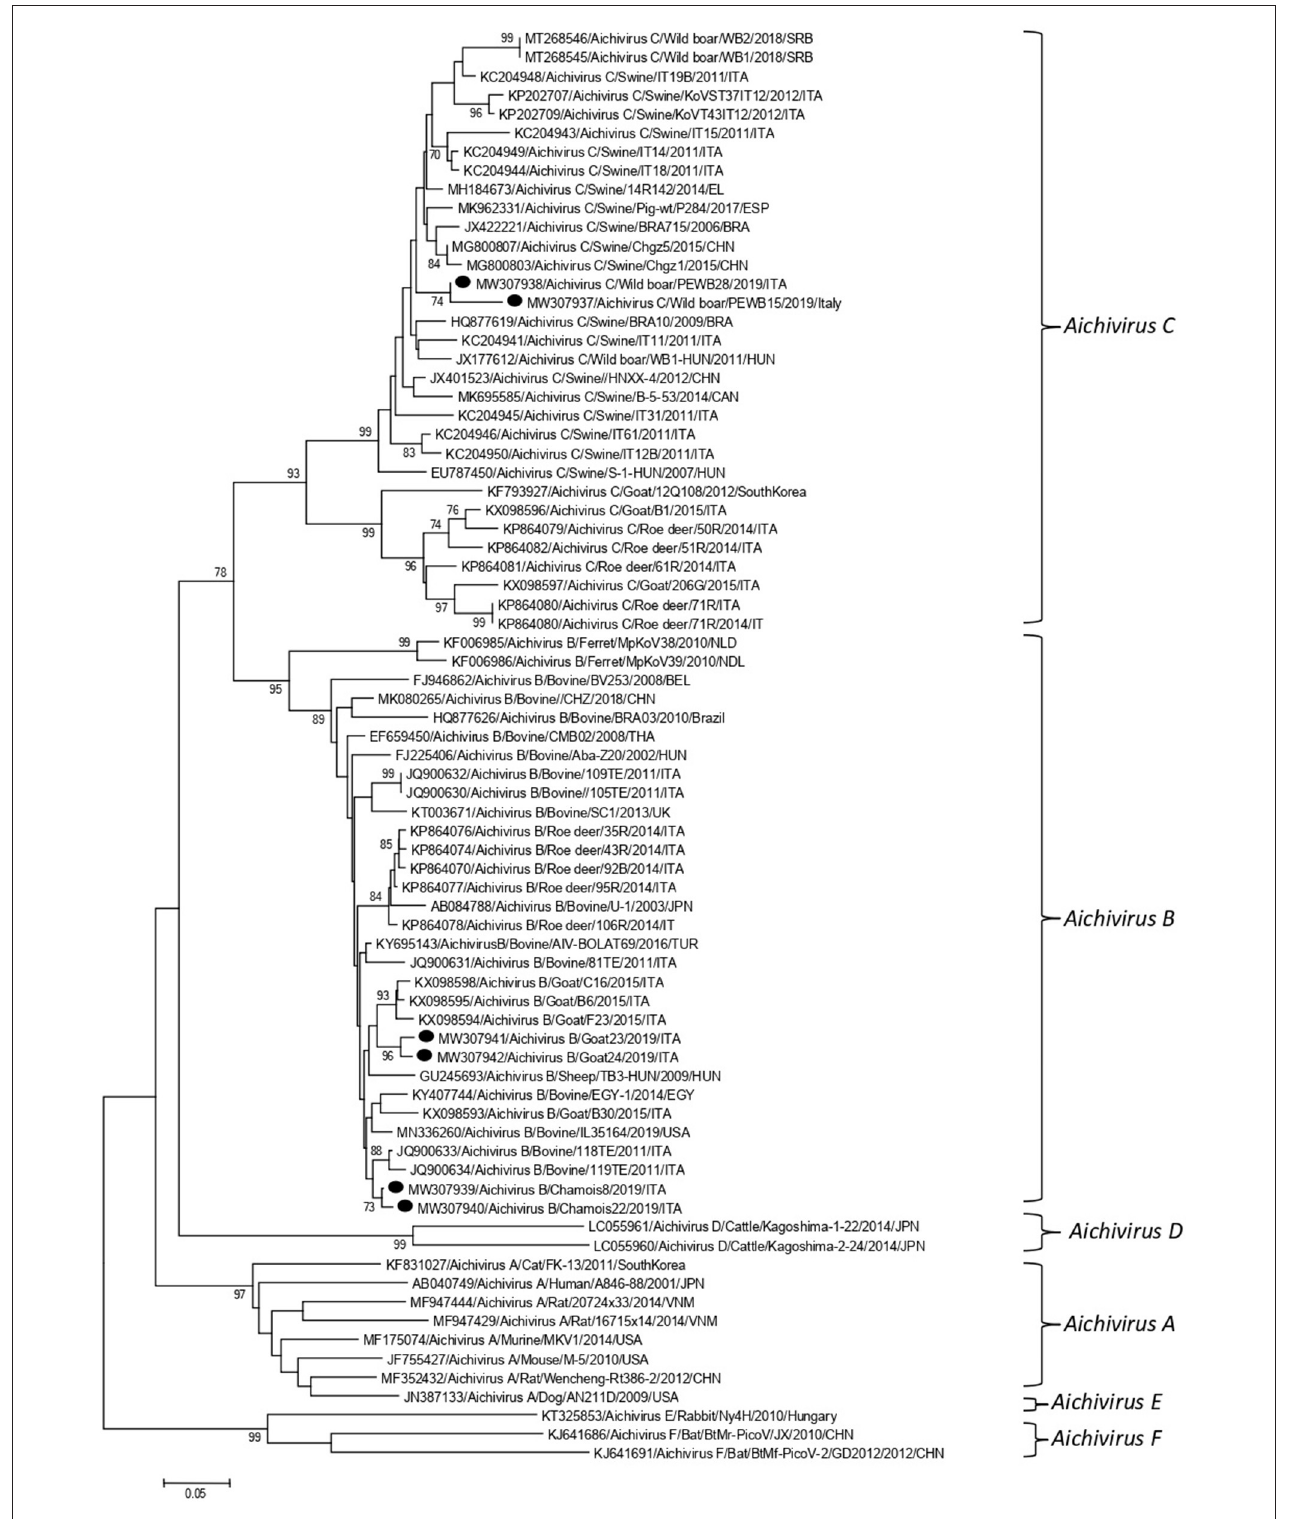
FIGURE 2 | Phylogenetic tree based on the nt sequence of the partial RdRp gene of the KoV strains detected in this study. A selection of 70 sequences representative of the genus Kobuvirus was retrieved from GenBank. The tree was generated using the neighbor joining method and kimura 2-parameter model supplying statistical support with bootstrapping of 1,000 replicates. Labels indicate KoVs identified in this survey.